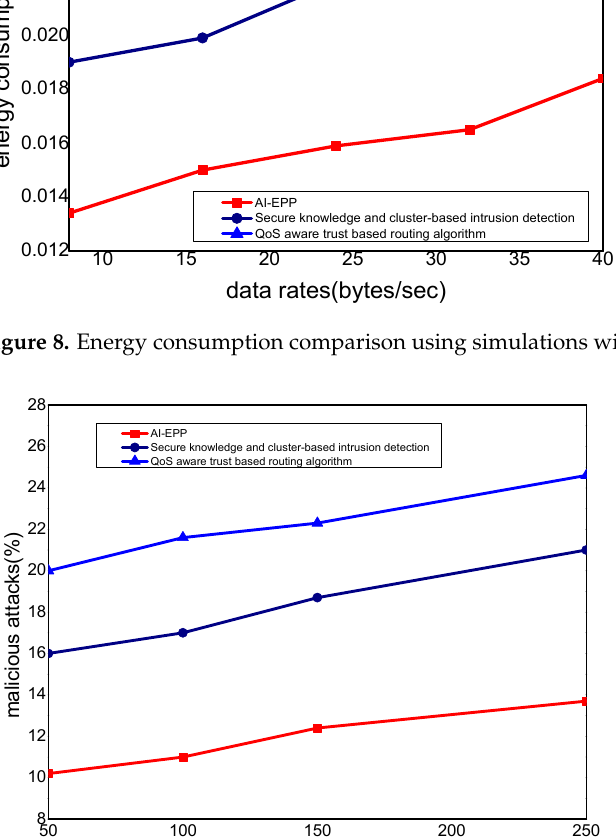
Figure 9. Malicious attacks comparison using simulations with varying number of nodes.